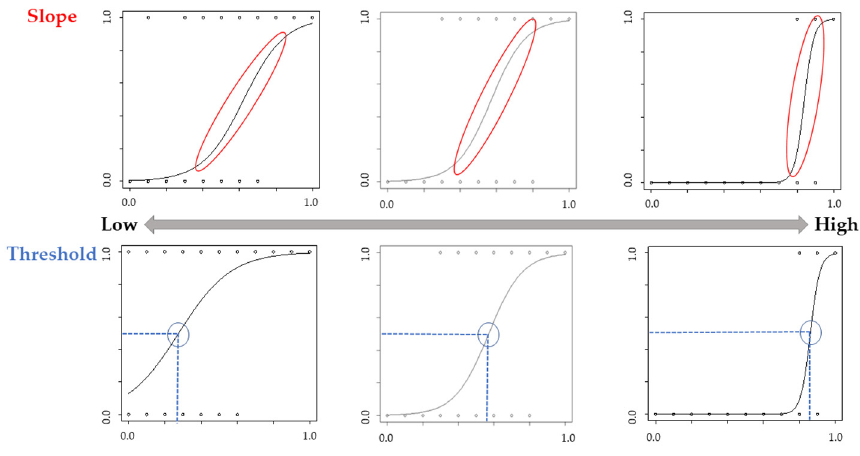
Figure 3. Image of the slope and threshold. A high positive slope indicates that the participants were judged as having their own movement, whereas a low slope indicates that participants ambiguously judged the movement as their own. A high threshold value indicates that they did not judge the movement as their own unless it reflected more of their own movement, whereas a low threshold value indicates that the movement was judged as one’s own, even if it did not reflect one’s own movement significantly.